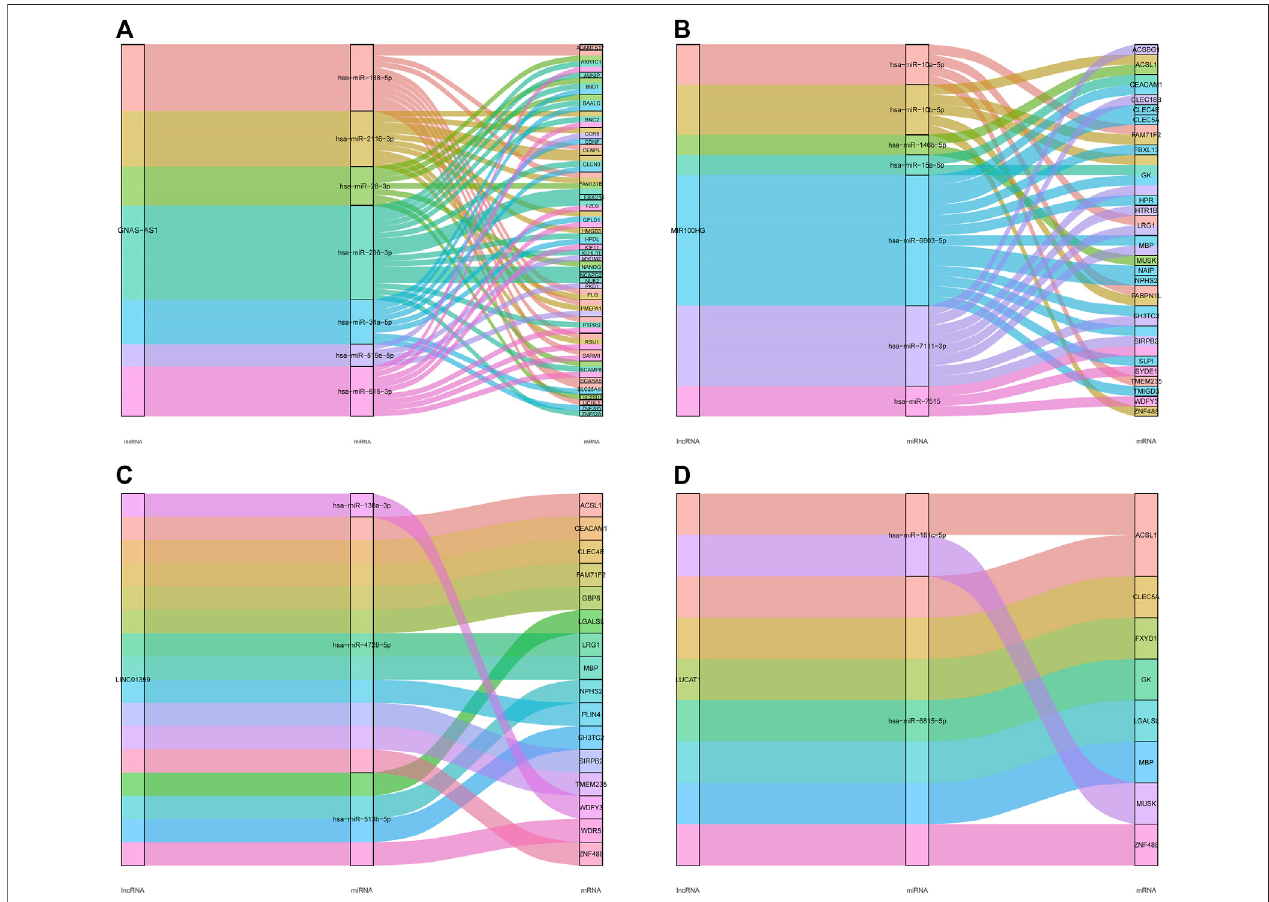
FIGURE 7 | LncRNA-miRNA-mRNA subnetwork of the four key lncRNAs. (A) The lncRNA GNAS-AS1-miRNA-mRNA network. (B) The lncRNA MIR 100HG- miRNA-mRNA network. (C) The lncRNA LINC01359-miRNA-mRNA network. (D) The lncRNA LUCAT1-miRNA-mRNA network.